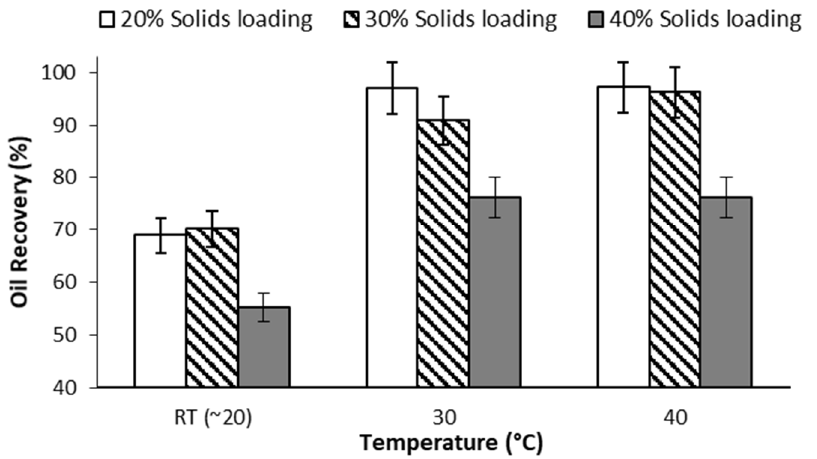
Figure 3. Effects of temperature on oil recovery from heavy fraction (# 20 sieved and aspirated) DDGS at 20%, 30%, and 40% solids loadings.